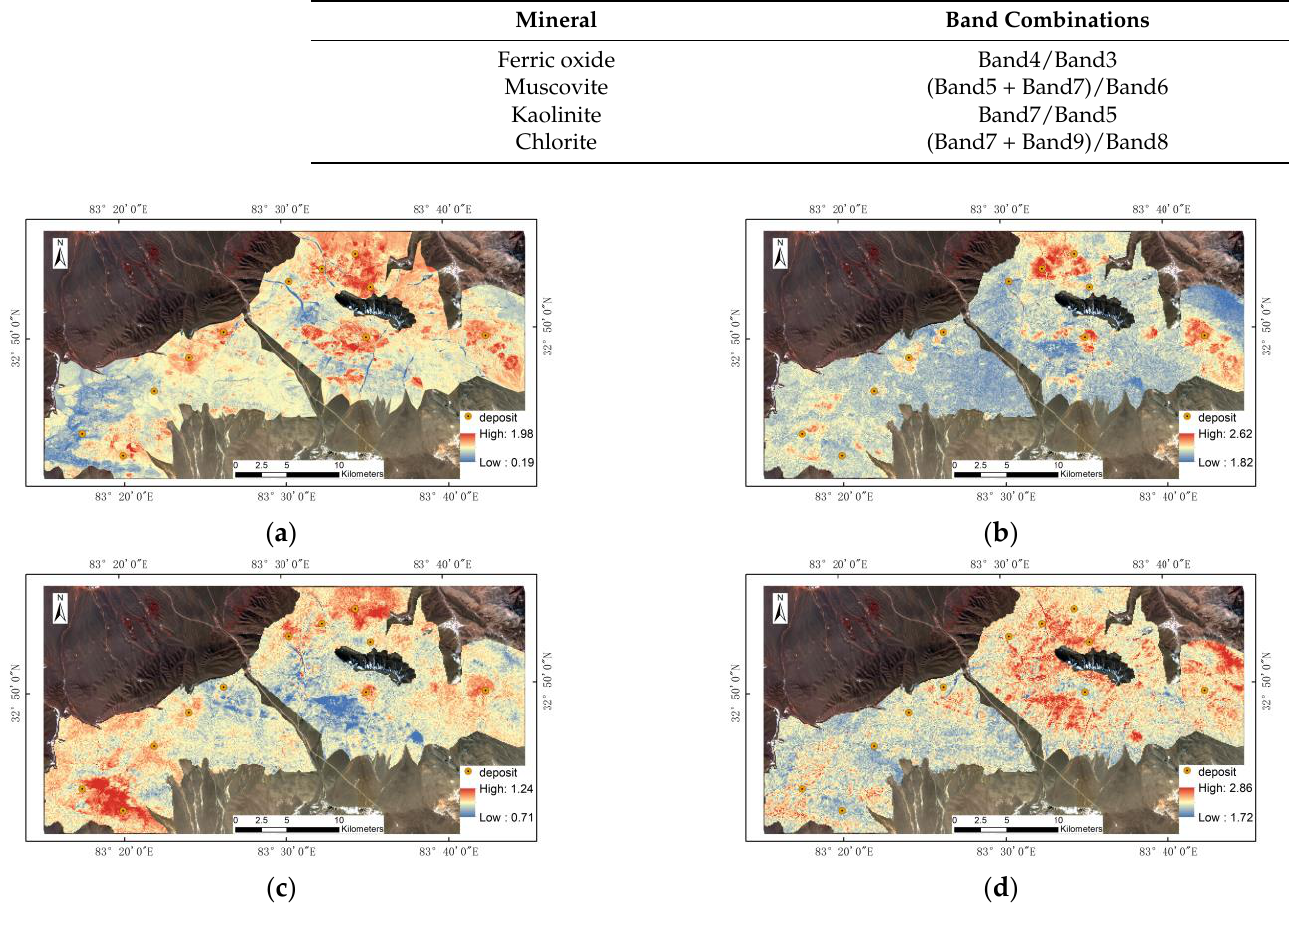
Figure 10. Mineral mapping results based on ASTER data in Duolong: ( a ) ferric oxide; ( b ) muscovite; ( c ) kaolinite; and ( d ) chlorite.